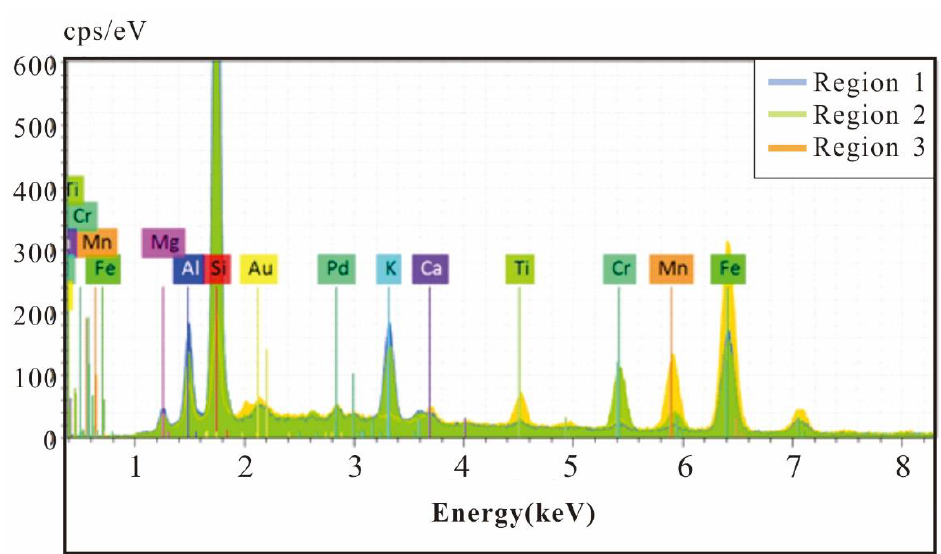
Figure 7. Division map of polymetallic nodules EDS scan area. ( a ) total area; ( b ) region 1; ( c ) region 2; ( d ) region 3. Table 1. Normalized mass concentration (The value is the percentage of